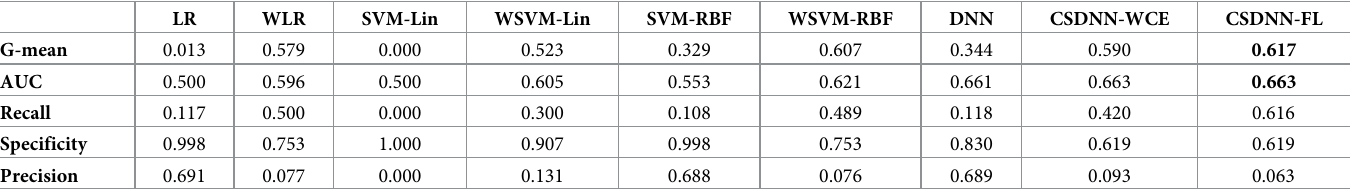
Table 16. Comparative results of CSDNN-WCE and CSDNN-FL against Logistic Regression (LR), Weighted LR, Support Vector Machine (SVM-Lin), Weighted SVM-Lin (WSVM-Lin), SVM with Radial Basis Function (SVM-RBF), Weighted SVM-RBF (WSVM-RBF), and DNN using Texas data. The highest average G-mean and AUC values are denoted in bold.